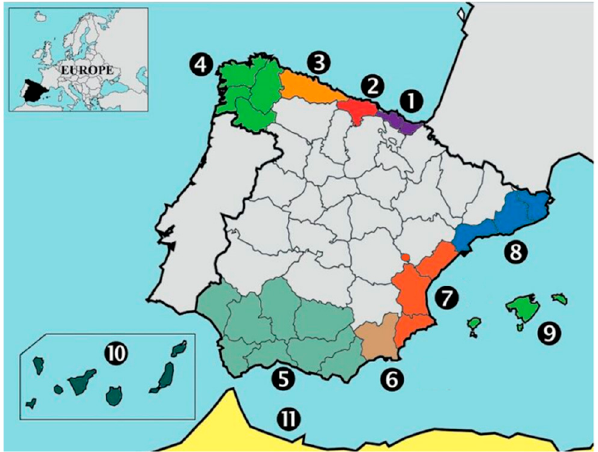
Figure 2. Distribution of coastal regions of Spain. Basque Country (1), Cantabria (2), Asturias (3), Galicia (4), Andalusia (5), Com. Murcia (6), Com. Valencia (7), Catalonia (8), Balearic Islands (9), Canary Islands (10) and Ceuta and Melilla (11). Source: Authors.